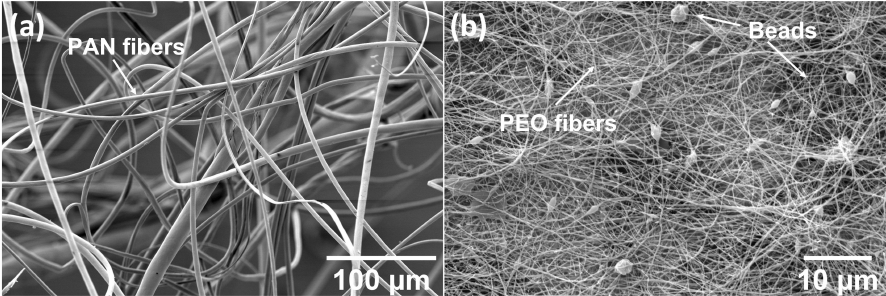
Figure 3. ( a ) Electrospun Polyacrylonitrile (PAN) fibers. ( b ) Electrospun Poly(ethylene oxide) (PEO) fibers.